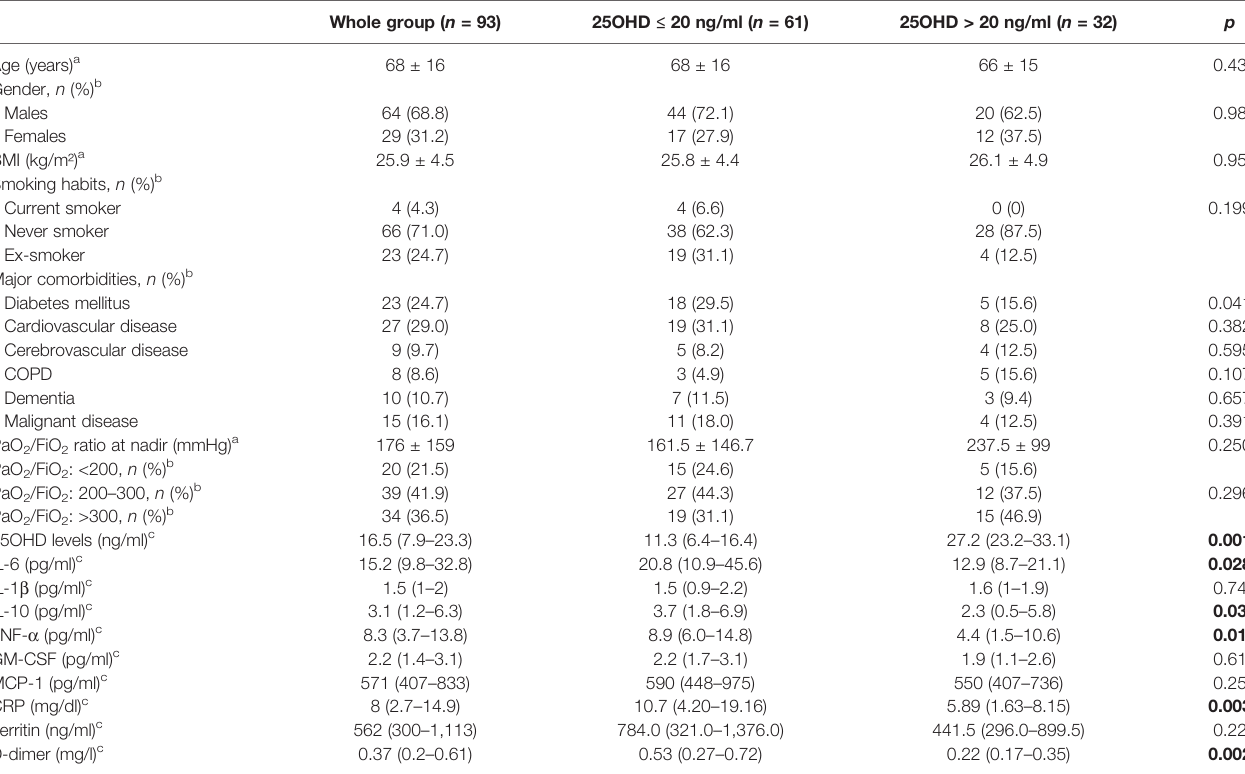
TABLE 1 | Clinical and biochemical characteristics of patients in the whole group of patients and according to 25OHD levels (cutoff 25OHD = 20